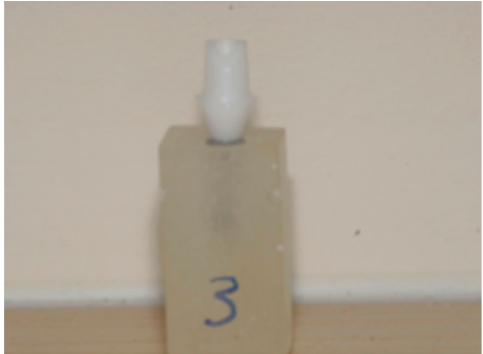
Figure 1. Implant-abutment assembly mounted on acrylic blocks.